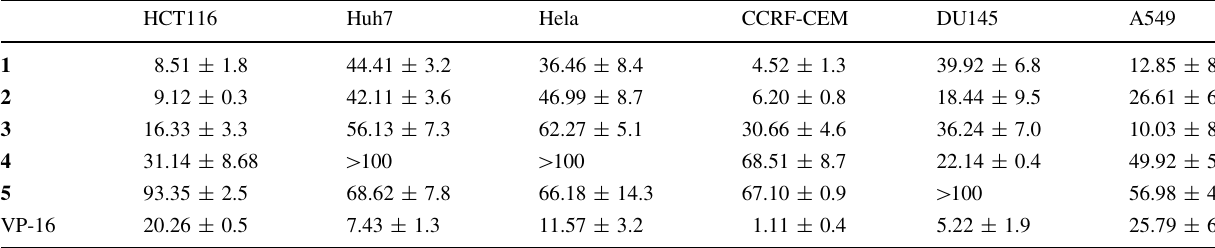
Table 2 Cytotoxicities with IC 50 values ( l M) of meroterpenoids 1 – 5 HCT116